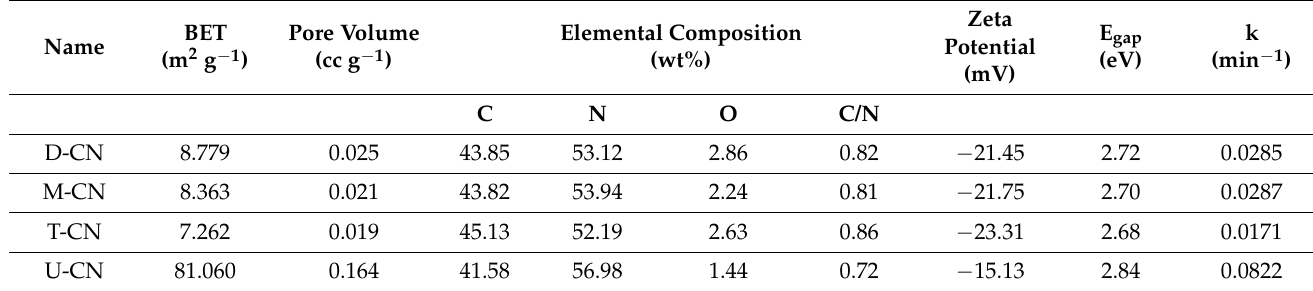
Table 1. Specific surface area and pore volume of as-prepared samples.